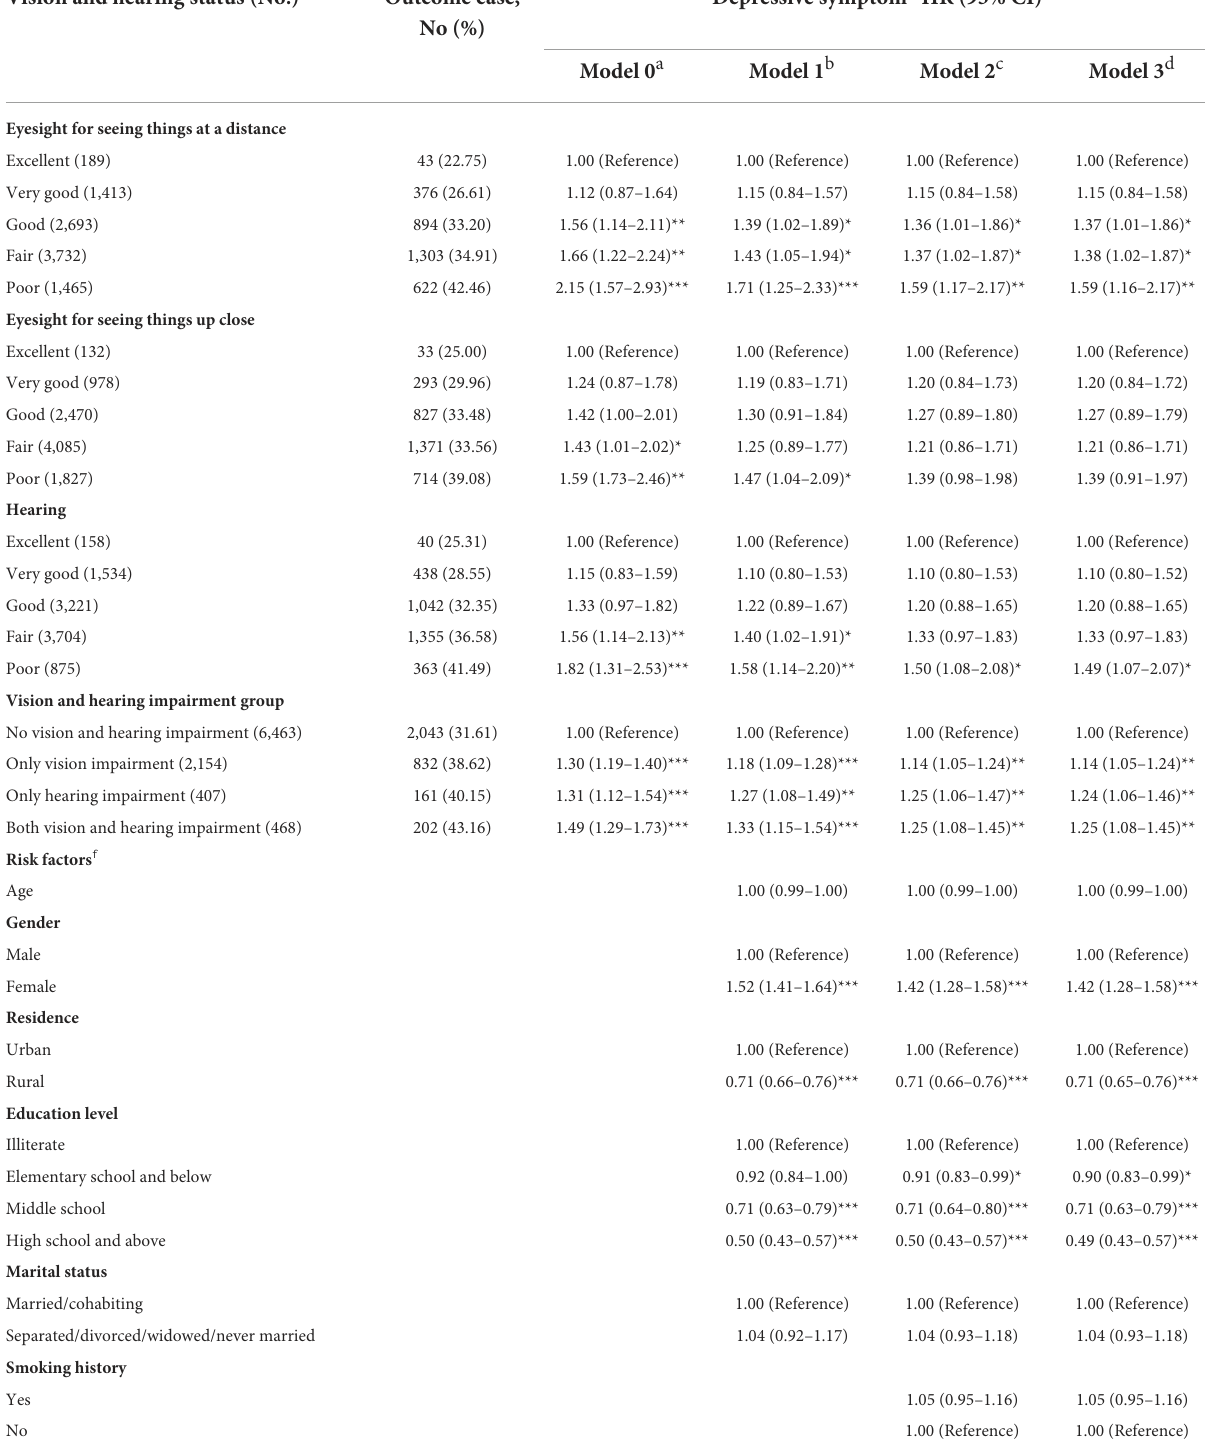
TABLE 3 Association of vision and hearing status with depressive symptoms among middle-aged and older Chinese adults. Vision and hearing status